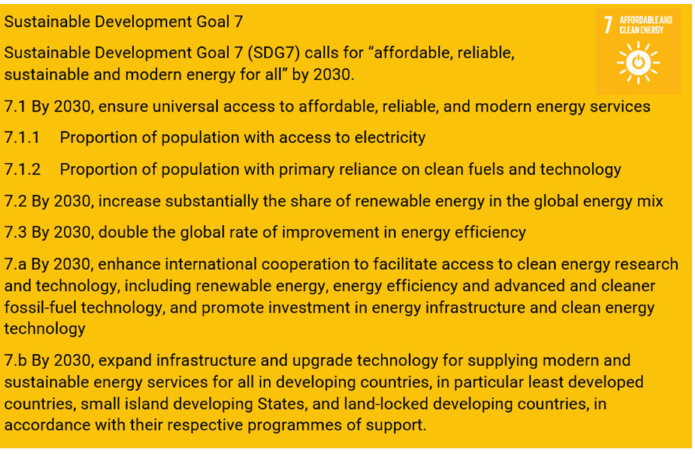
Figure 1. Summary of SDG 7 goal and indicators, derived from sdgs.un.org